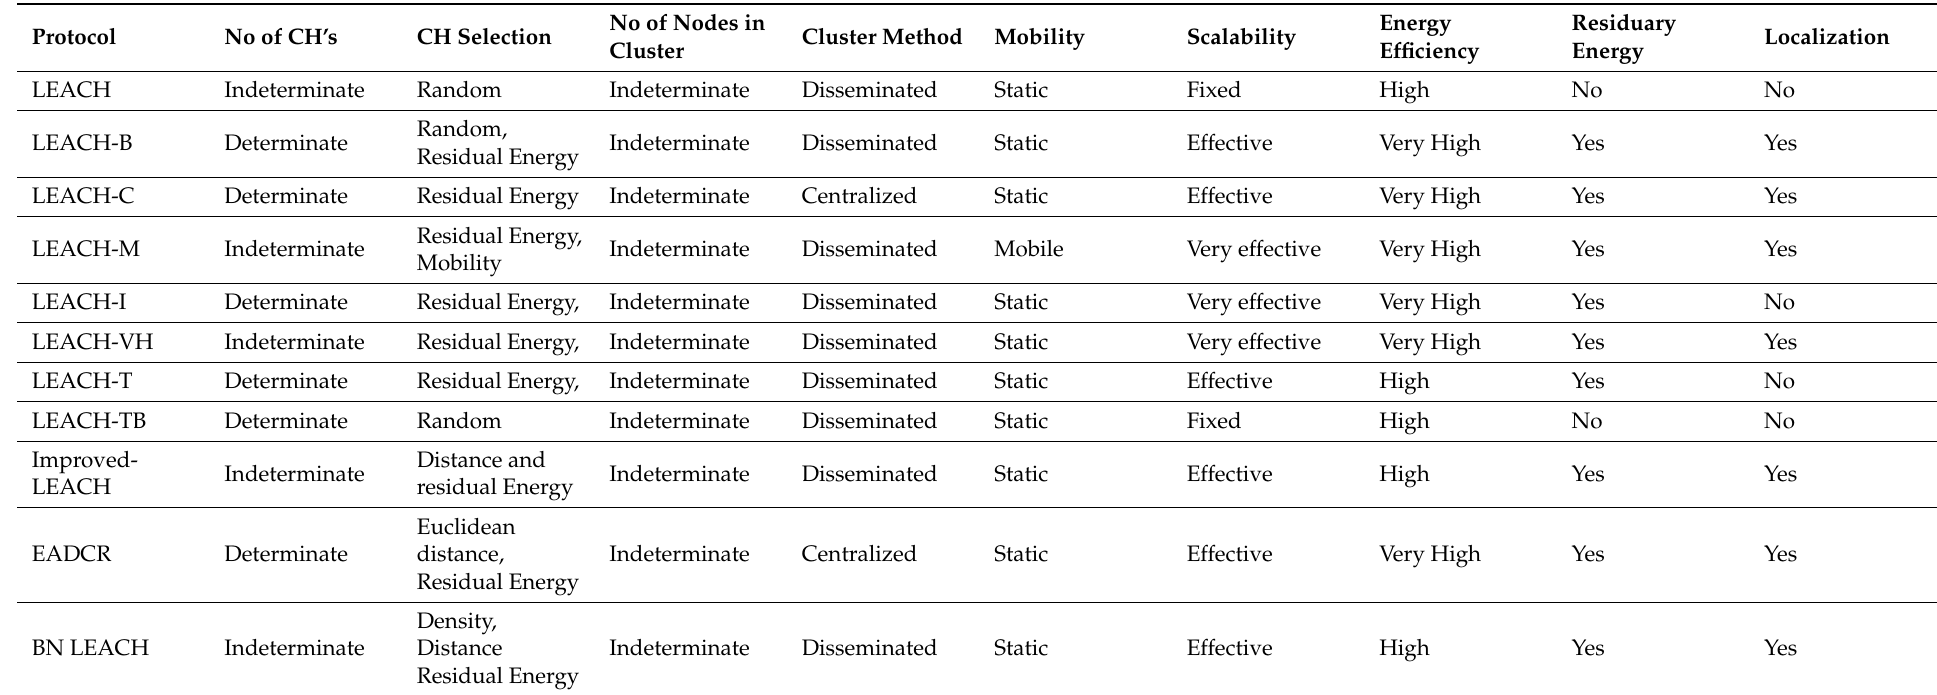
Table 3. Comparison based on certain